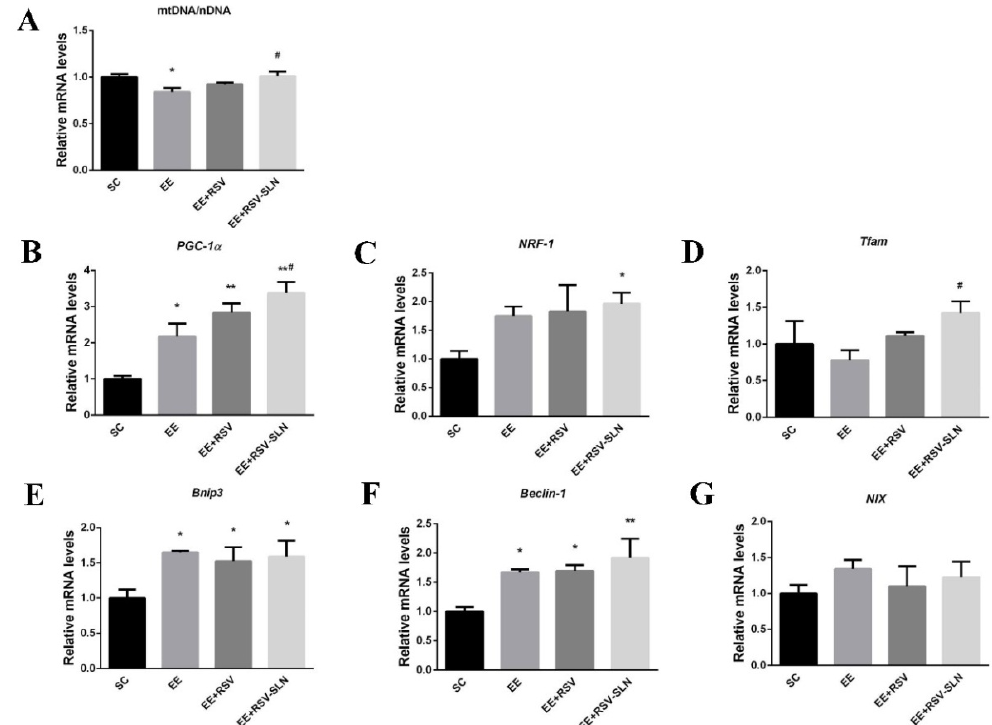
Figure 7. RSV-SLN elevates mitochondrial content by upregulating mitochondrial biogenesis and enhancing mitophagy capacity during excessive endurance exercise. ( A ) Mitochondrial DNA copy number (mtDNA). ( B – D ) The mRNA expression profile of mitochondrial biogenesis, PGC-1α , NRF1 , and Tfam . ( E – G ) The mRNA expression profile of mitophagy, Bnip3 , Beclin-1 , and NIX in the skeletal muscle from four groups of mice. * p < 0.05, and ** p < 0.01 vs. SC group; # p < 0.05 vs. EE group.